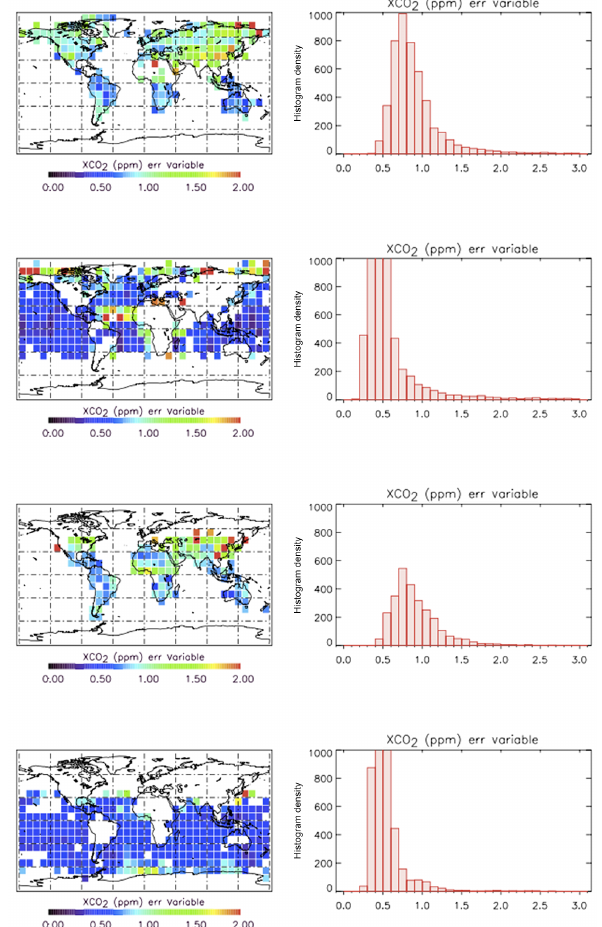
Figure 5. Variable error. Top: June, land; second row: June, ocean; third row: Dec. land; bottom: Dec.,